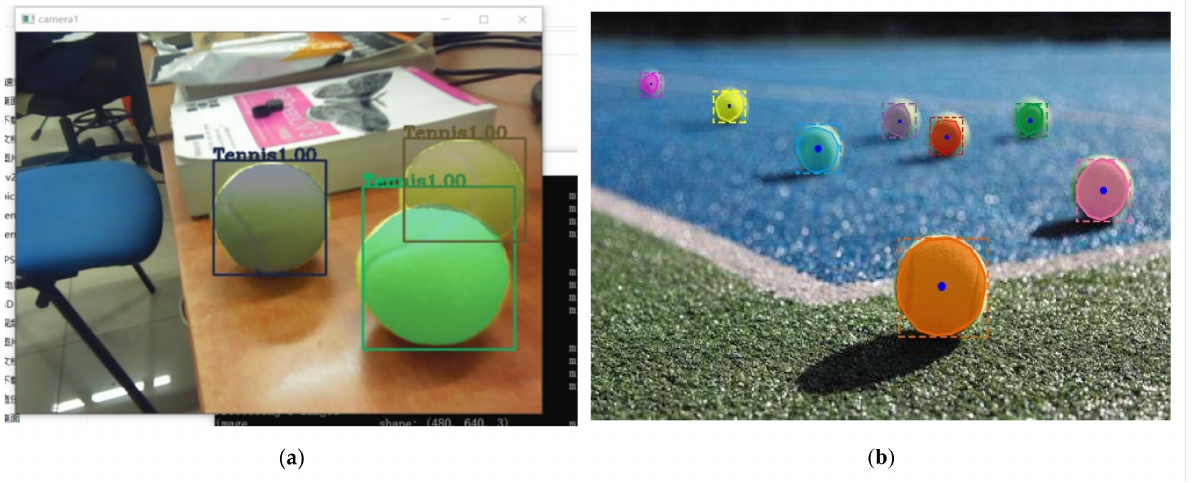
Figure 25. Recognition effect diagram. ( a ) Identifying tennis balls indoors, ( b ) identifying tennis balls